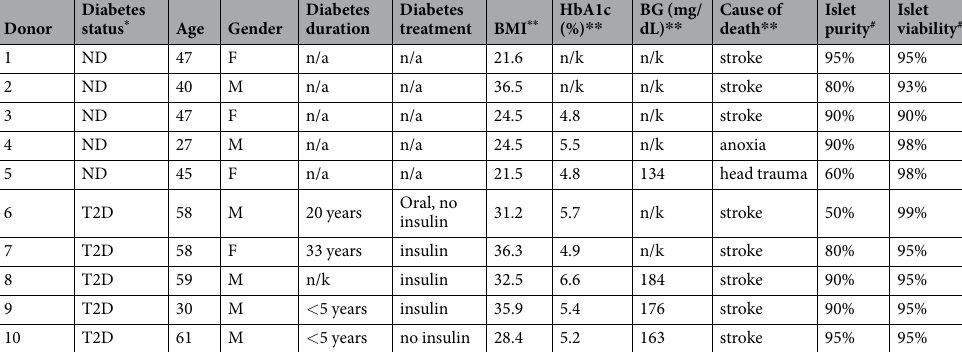
Table 1. Human islets donor information. ND: non-diabetic; T2D: type 2 diabetic; n/a: not applicable; n/k: not known. * : Diabetes status is based on doctors’ diagnosis on medical history. ** : Data obtained during terminal hospital stay. Blood glucose (BG) data means average BG during the terminal hospital stay. #: Information provided by islet providers (IIDP